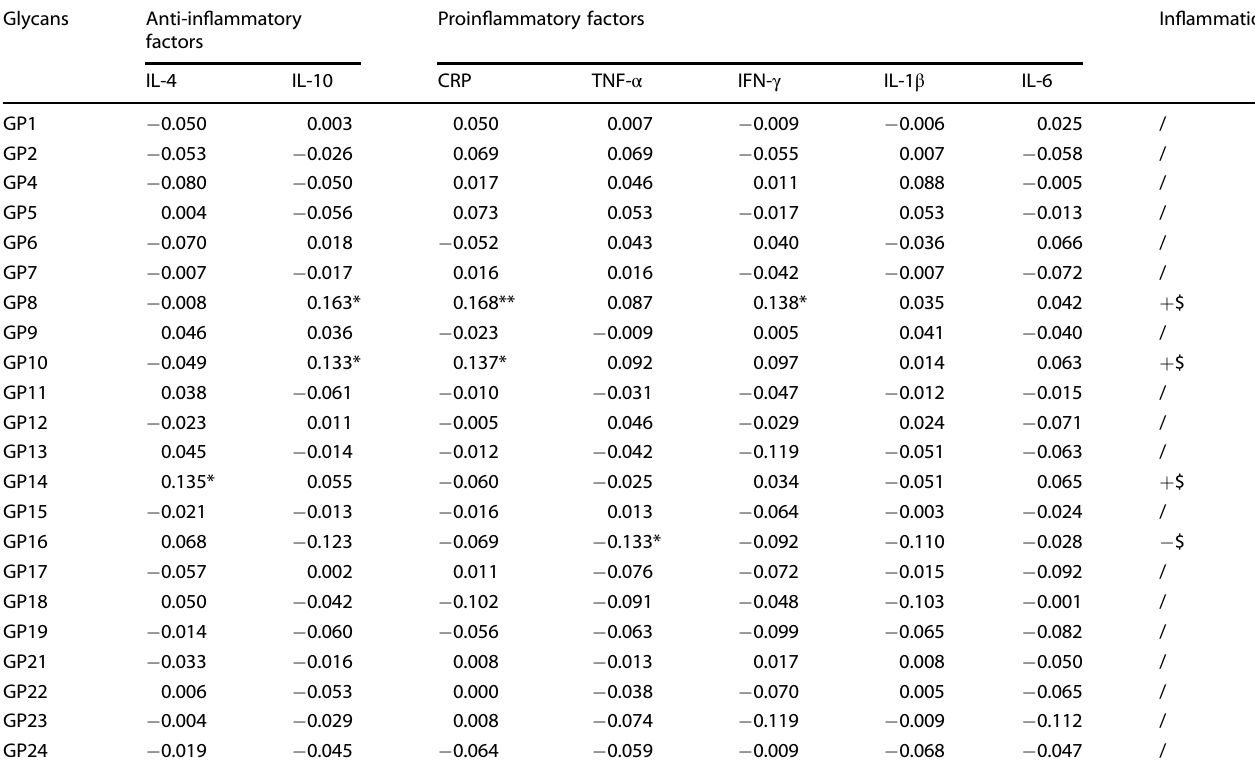
Table 4. Correlation coef fi cient ( r s ) between normalized initial glycans and in fl ammation